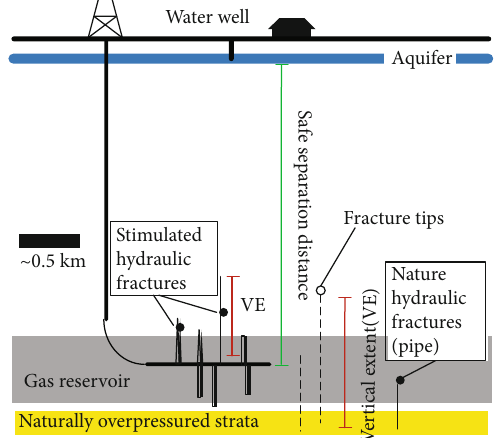
Figure 5: Schematic diagram showing stimulated hydraulic fractures within a shale gas reservoir